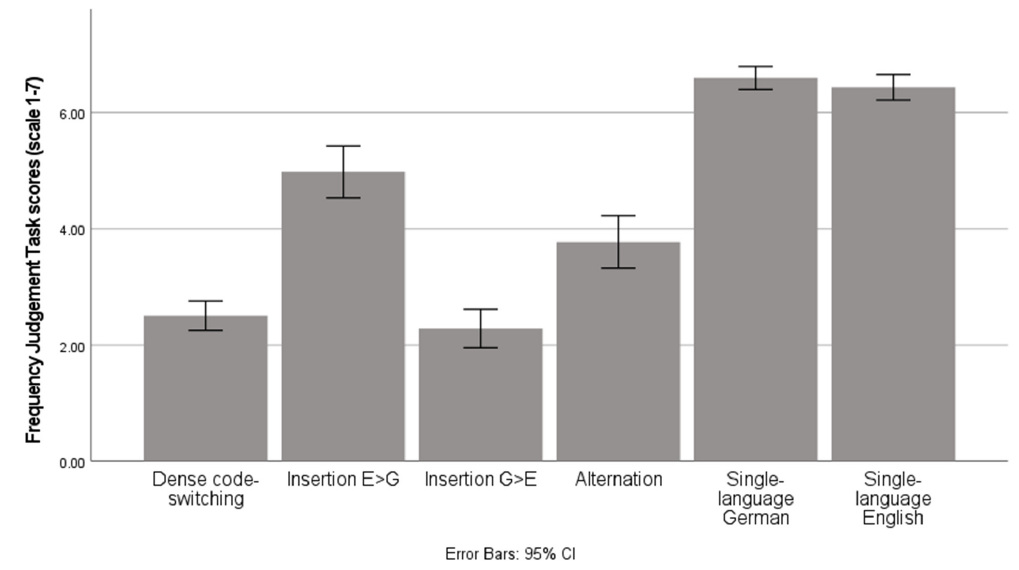
Figure 2. Frequency judgement task scores (scale 1 to 7).